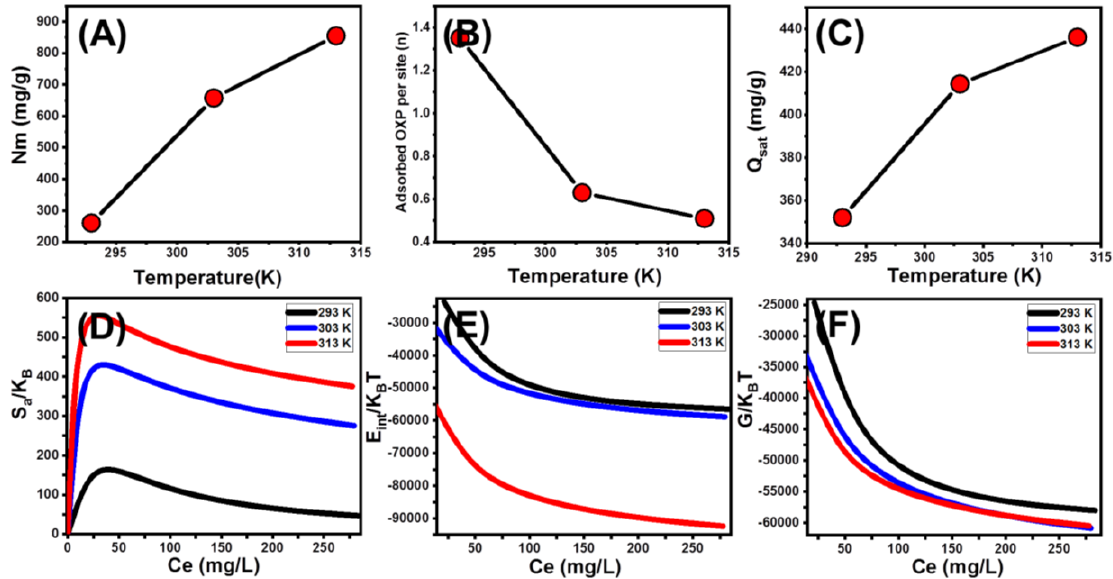
Figure 4. Effect of pH on the adsorption of C.R by Mg/CFC [dosage: 0.2 g/L; contact interval: 24 h; concentration: 50 mg/L; temperature: 293 K] ( A ), adsorption properties of Mg/CFC at different concentrations of C.R [dosage: 0.2 g/L; contact interval: 24 h; pH: 2] ( B ), fitting of the C.R adsorption data with Langmuir isotherm ( C ), fitting of the C.R adsorption data with Freundlich isotherm ( D ), fitting of the C.R adsorption data with D-R isotherm ( E ), and fitting of the C.R adsorption data with advanced monolayer model with one energy ( F ).